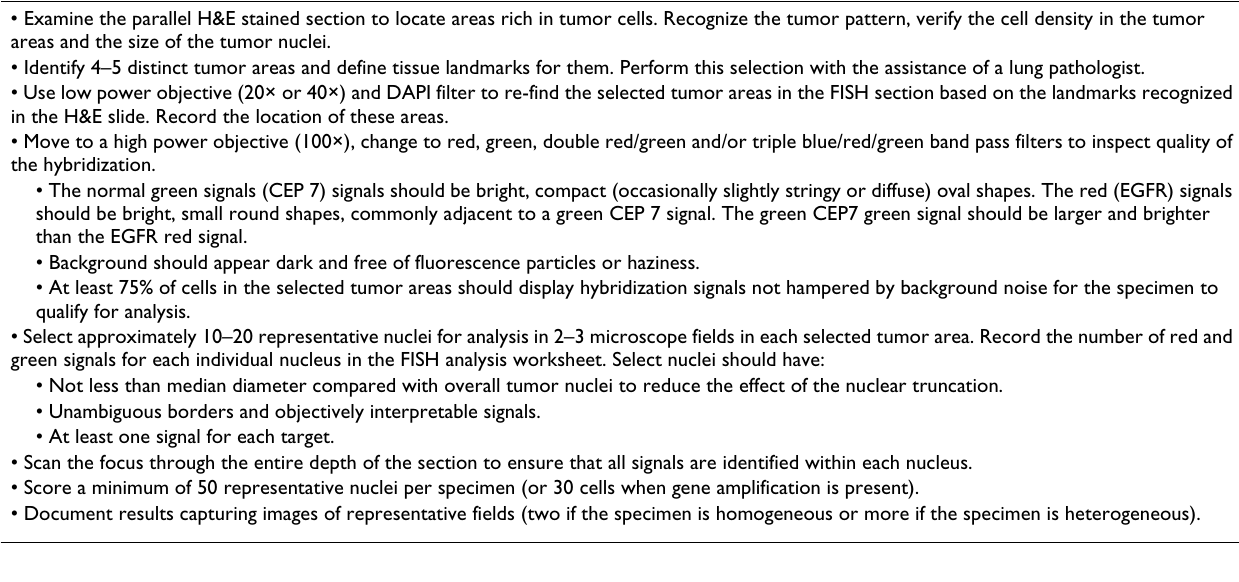
Table 1: Guidelines for Microscope Analysis of NSCLC tissue sections hybridized with the SpectrumOrange LSI EGFR/SpectrumGreen CEP 7 FISH probe set (Vysis/Abbott Molecular) at